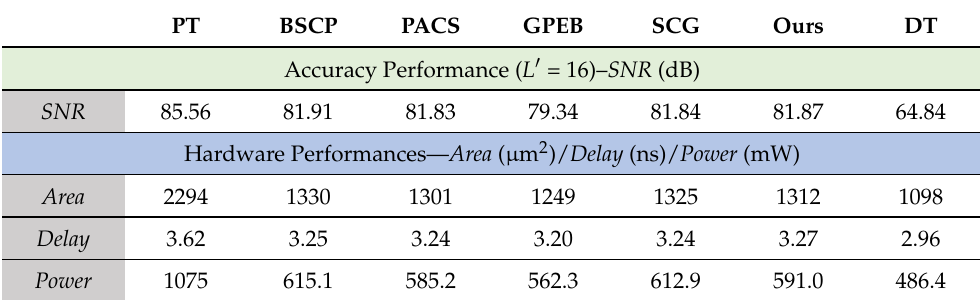
Table 5. Comparison of accuracy and hardware performances of a 16-bit fixed-width Booth multiplier (FWBM) for PT, DT, and various truncation error compensation (TEC) schemes.